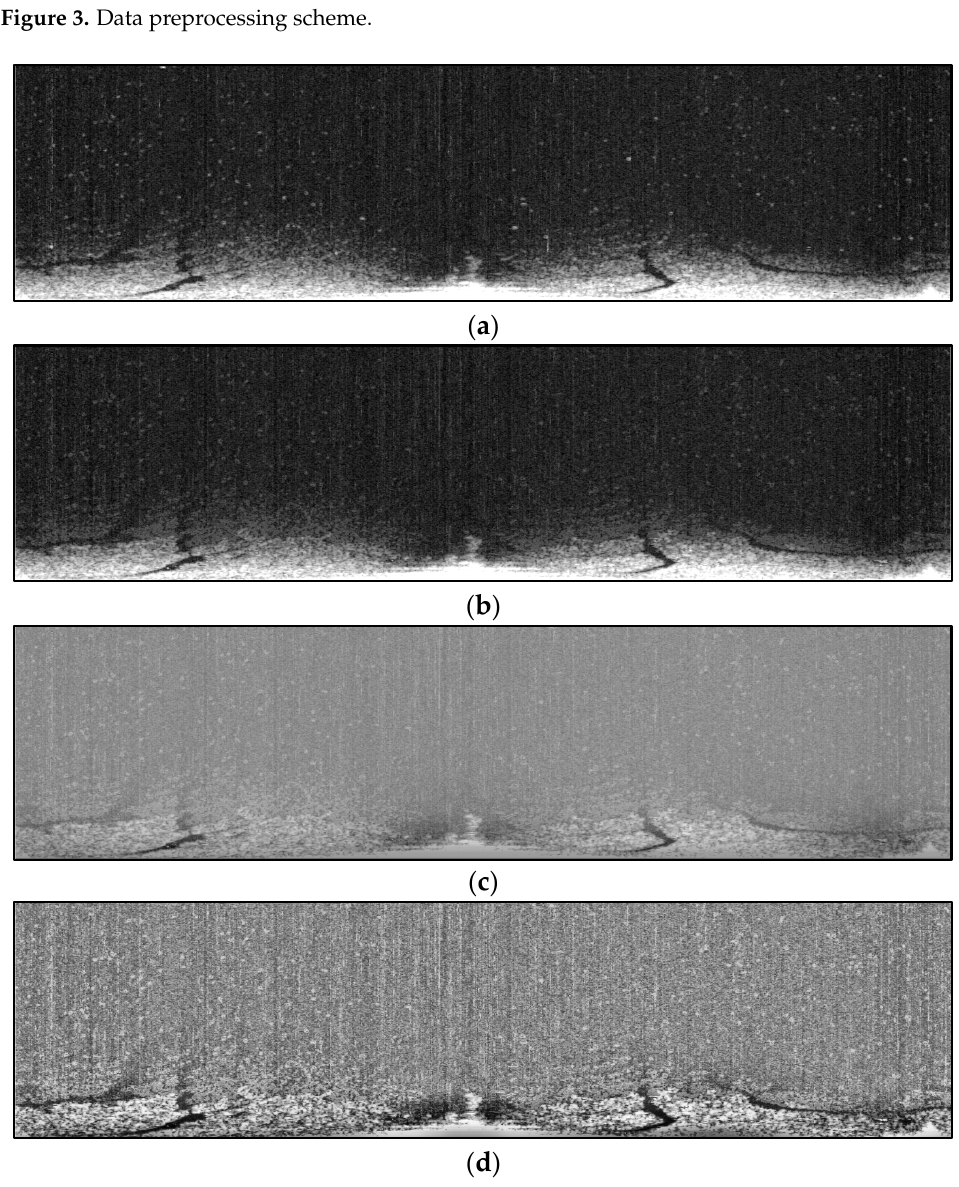
Figure 4. The preprocess. ( a ) Co-frequency interference noise suppression; ( b ) Speckle noise reduc- tion; ( c ) Gray correction image; ( d ) Local contrast enhanced image. tion; ( c ) Gray correction image; ( d ) Local contrast enhanced